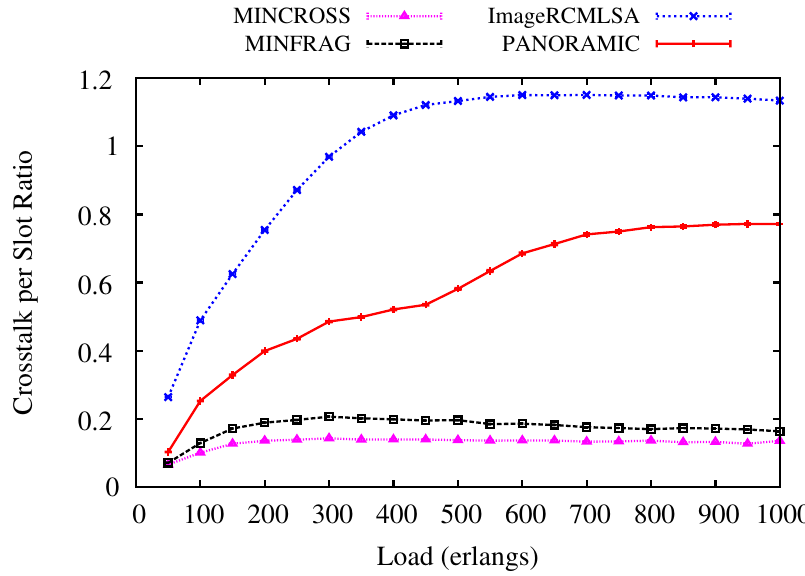
Figure 11. Crosstalk per Slot for NSF